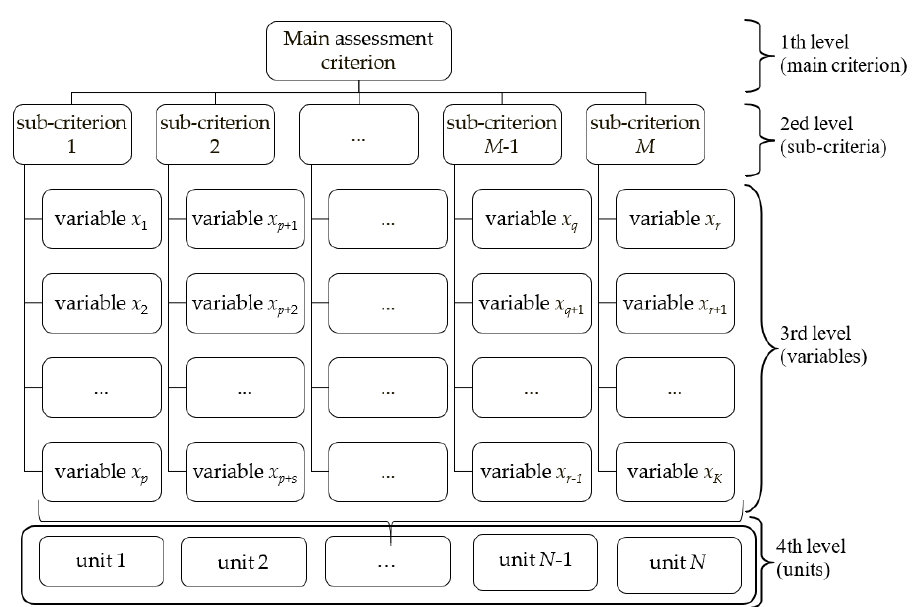
Figure 2. Hierarchical structure for the multi-criteria assessment of units.